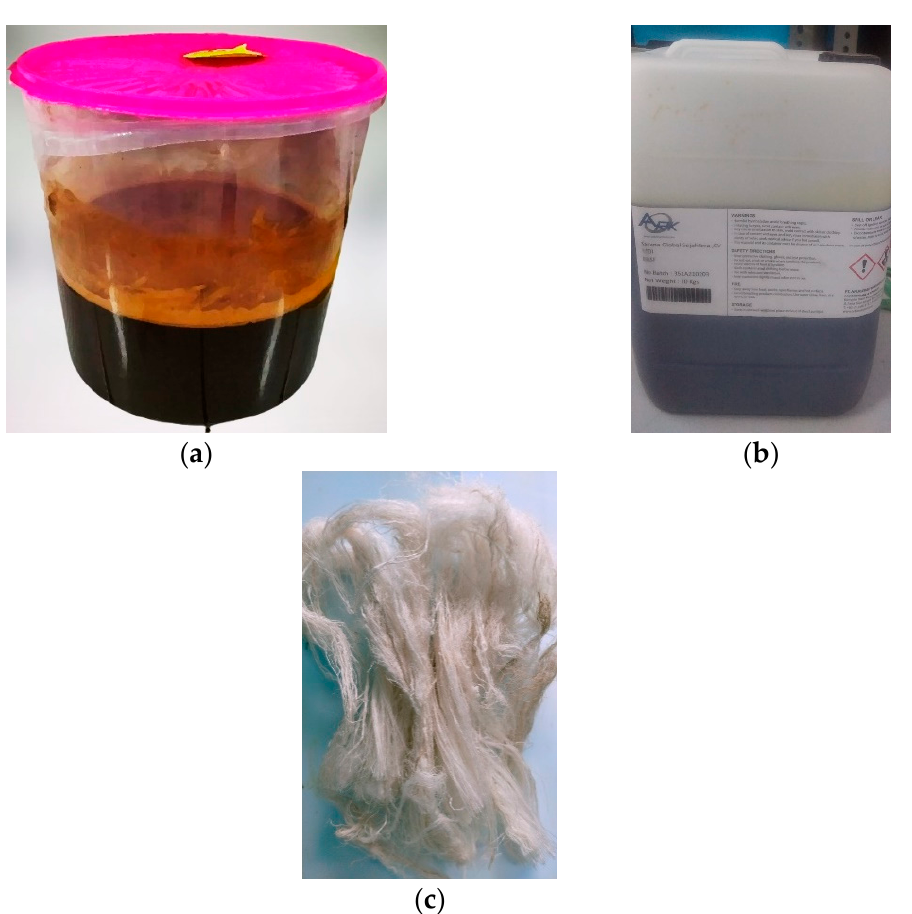
Figure 1. The materials used ( a ) black liquor; ( b ) pMDI; ( c ) ramie fibers.